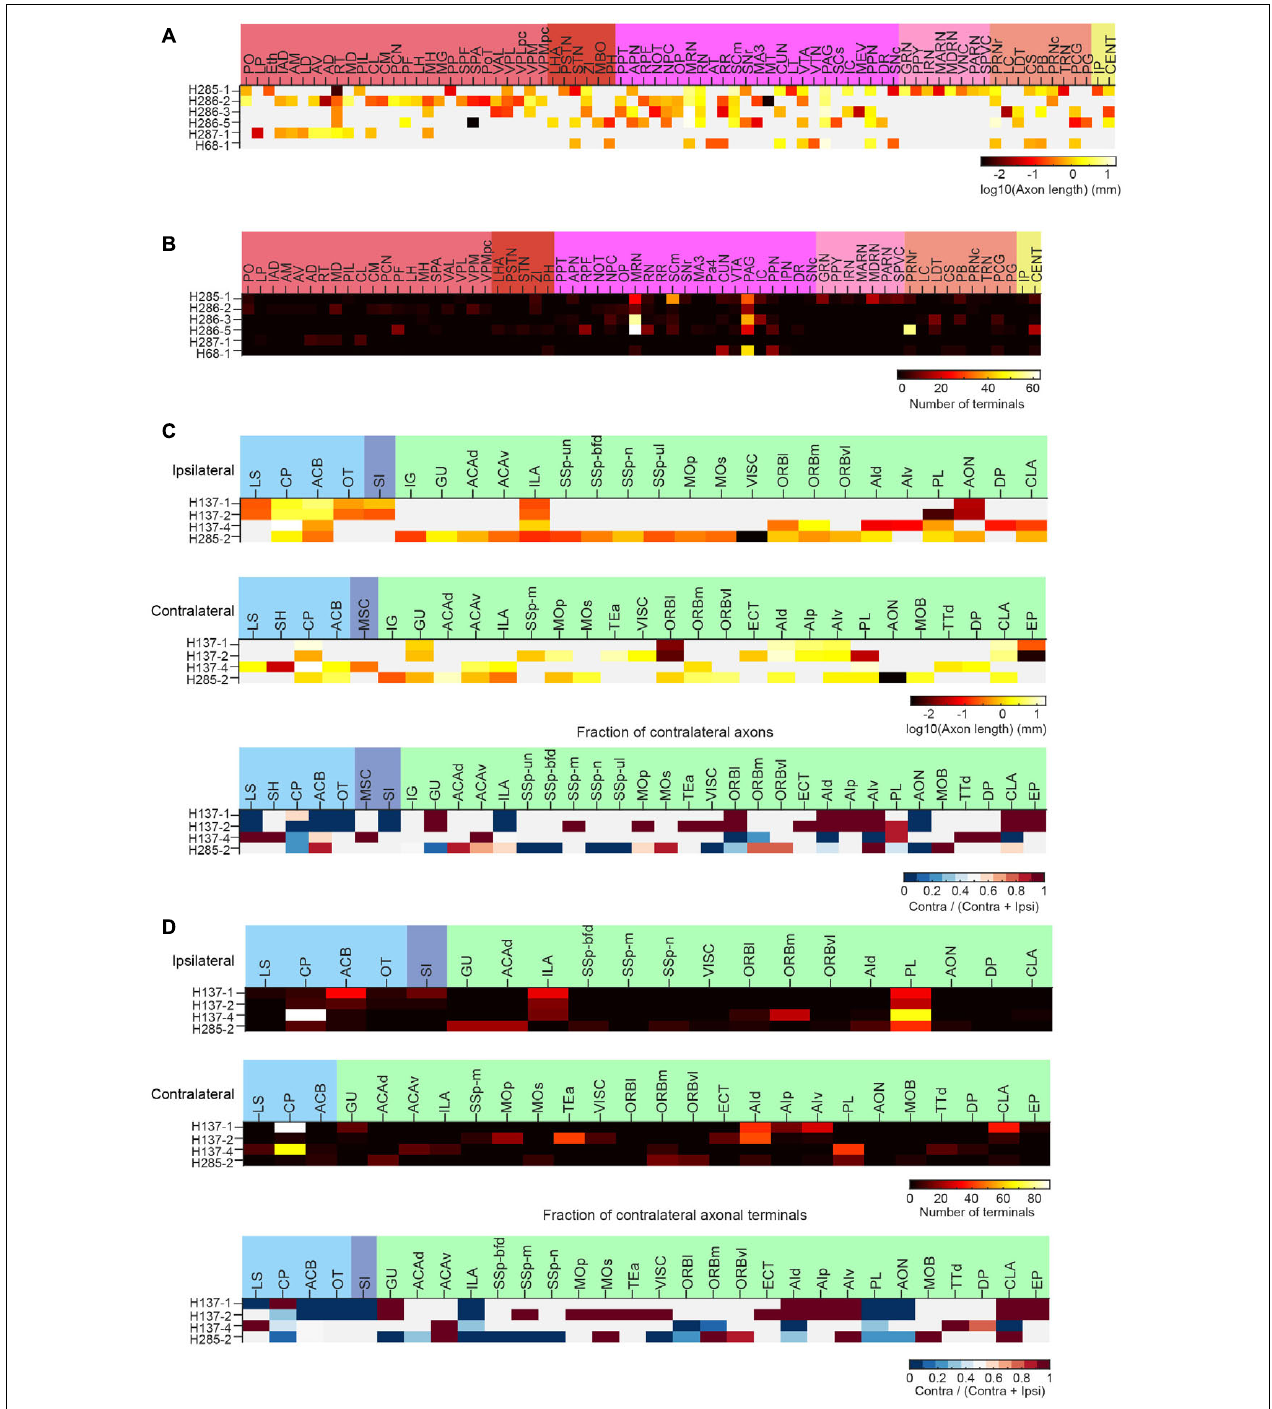
FIGURE 14 | Long-range projections of mPFC ET and IT neurons. (A) Axonal length of individual ET neurons in different cortical and subcortical areas in the ipsilateral hemisphere. (B) Number of axonal terminals of individual ET neurons in the ipsilateral hemisphere. There are no terminals in the contralateral hemisphere for the reconstructed ET neurons. (C) Axonal length of individual IT neurons in different cortical and striatal areas in the ipsilateral (top) or contralateral (middle) hemisphere. The normalized fraction of axonal length in the contralateral hemisphere (to total axonal length) is shown in the bottom row. (D) Number of axonal terminals of individual IT neurons in the ipsilateral (top) or contralateral (middle) hemisphere. The normalized fraction of axonal terminals in the contralateral hemisphere (to total axonal length) is shown in the bottom row. There are more terminals in the ipsilateral hemisphere.